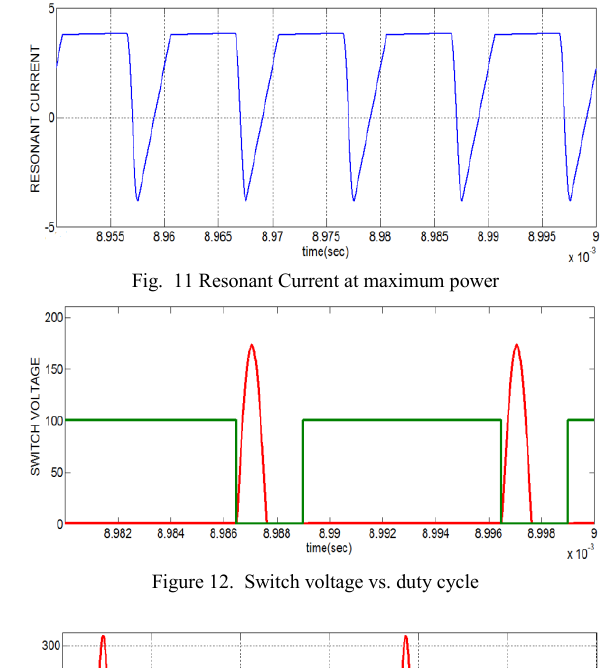
Fig. 8. Output voltage at maximum power